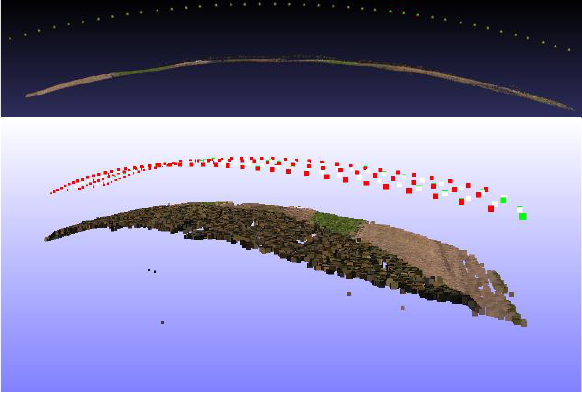
Figure 2. A view of the blow